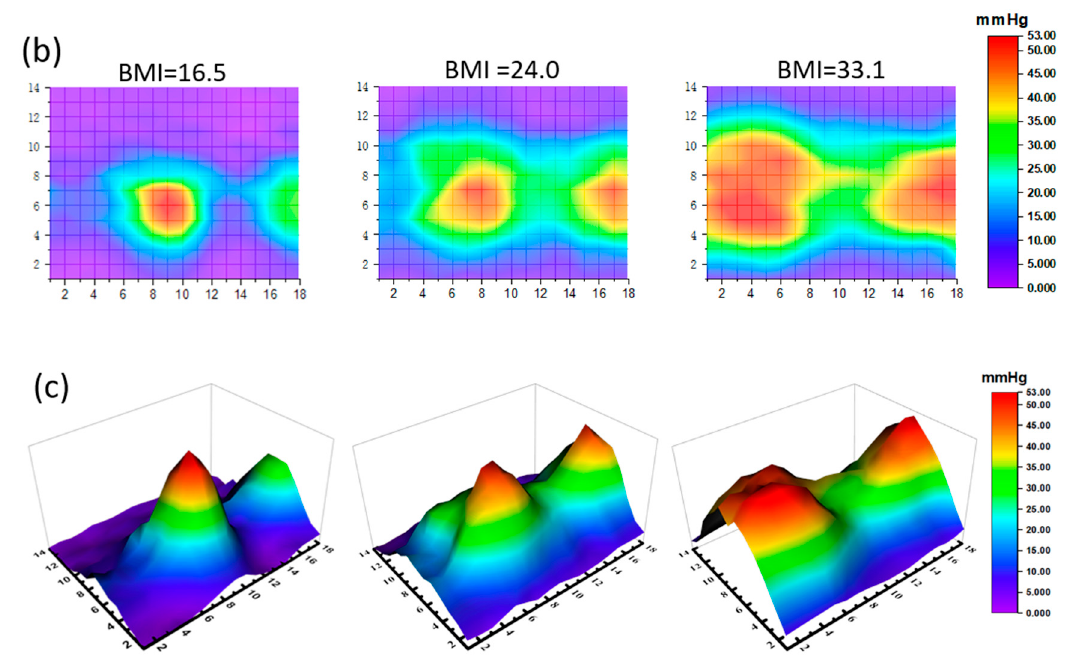
Figure 6. ( a ) Number of patients with and without pressure injury classified by the patient body mass index (BMI). Typical interfacial pressure distribution at the 3rd hour for patients with 3 different BMIs shown in ( b ) 2D and ( c ) 3D images.